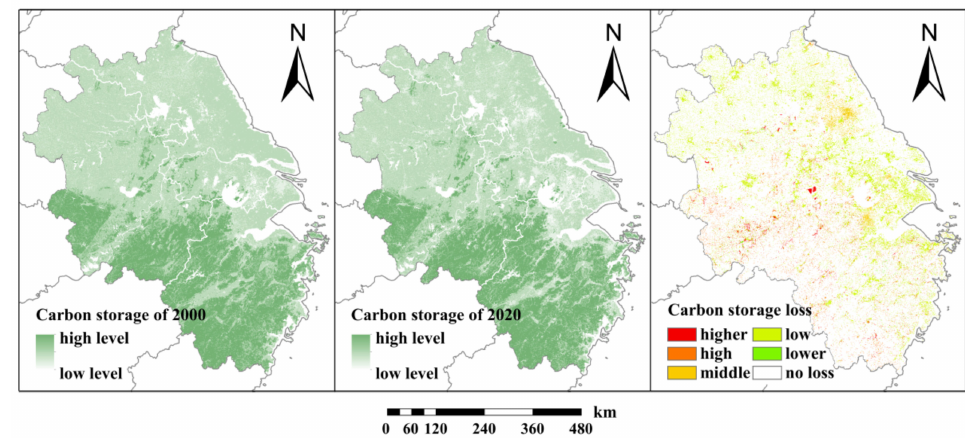
Figure 4. Patterns of carbon storage and loss in Yangtze River Delta from 2000 to 2020.